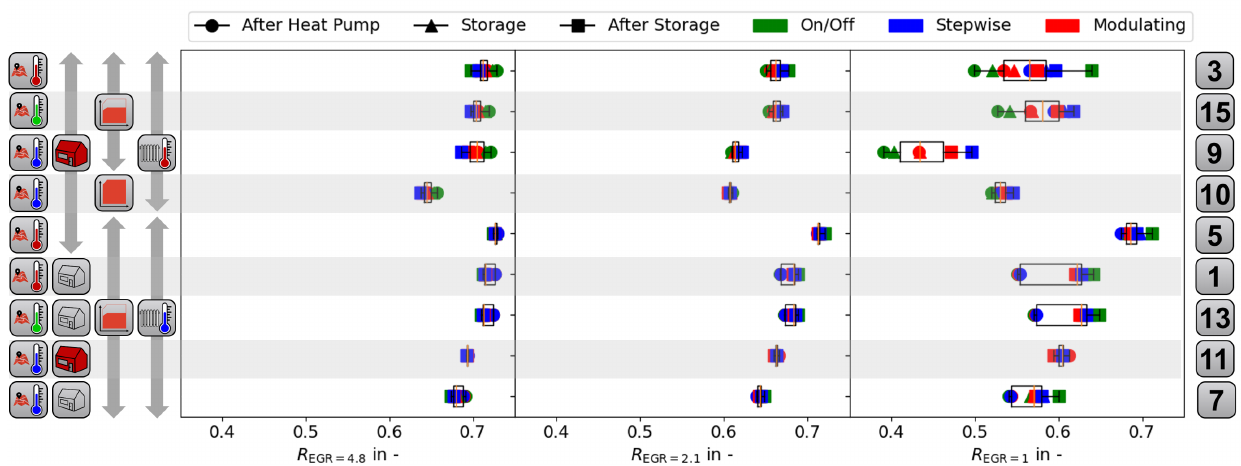
Figure 7. Boxplots of the reduction R in costs and emissions with different EGR for a selected set of scenarios. See Figure A2 for all scenarios.